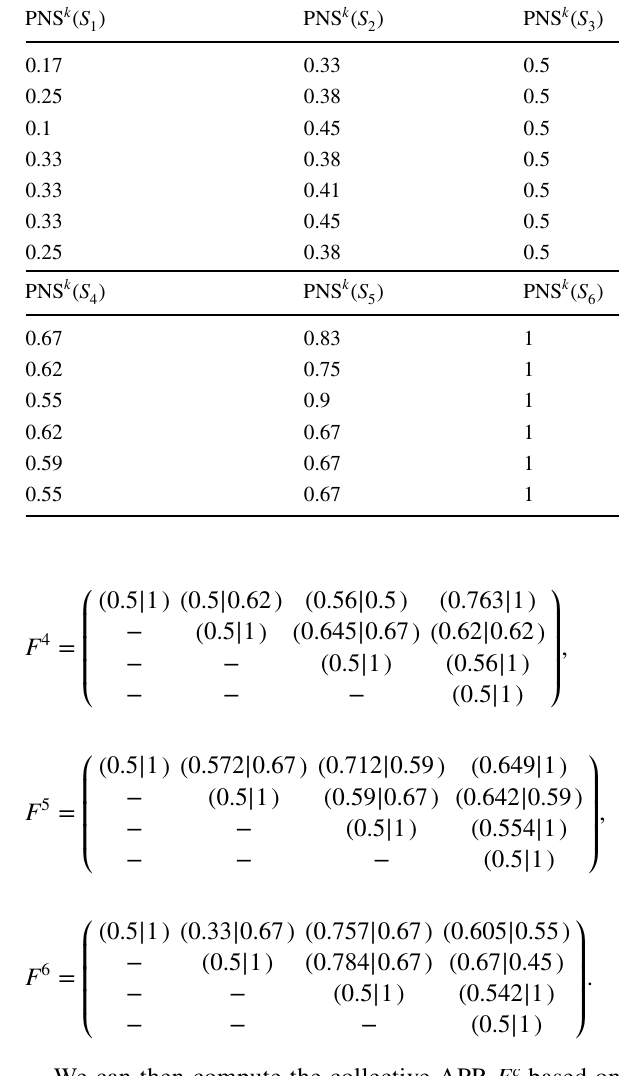
Table 2 PNS of linguistic terms for each